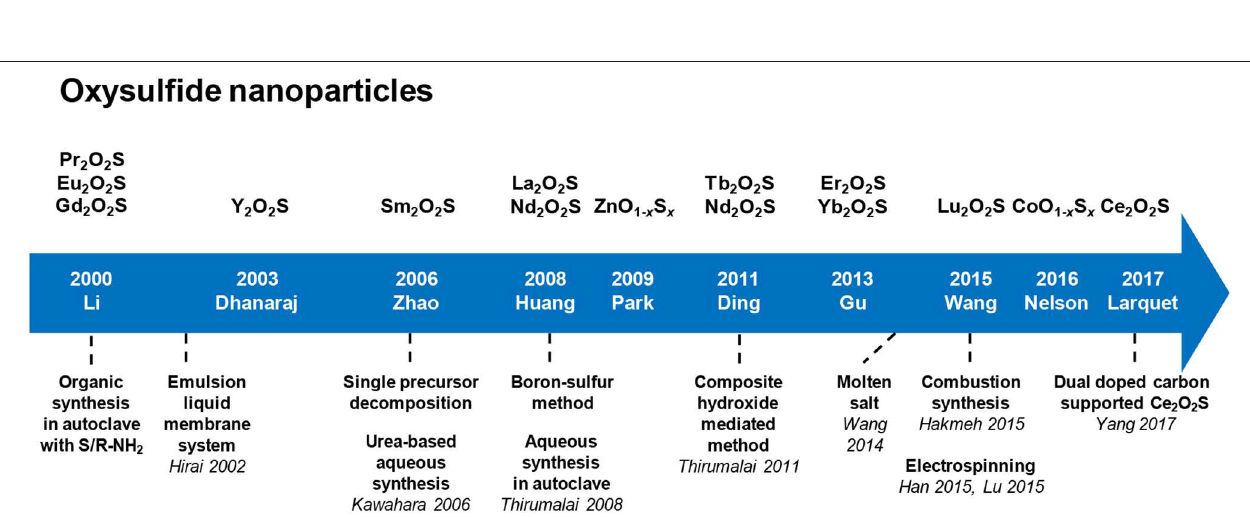
Frontiers in Chemistry |